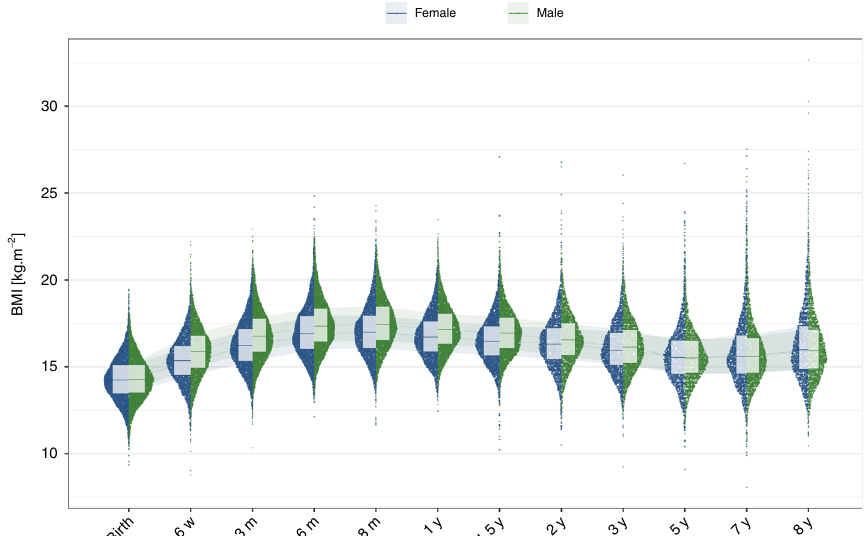
Fig. 1 BMI distribution at the 12 time points analysed. BMI values in kg ⋅ m − 2 for all samples (discovery and replication) are plotted at each time point. BMI values are uniformly distributed along the x -axis between the tick of the time point and the value of the normalized density of the sex-strati fi ed BMI at this time point, to the left for females (blue) and to the right for males (green). Ribbons and box plots, showing the median and quartiles, are plotted in background and foreground,